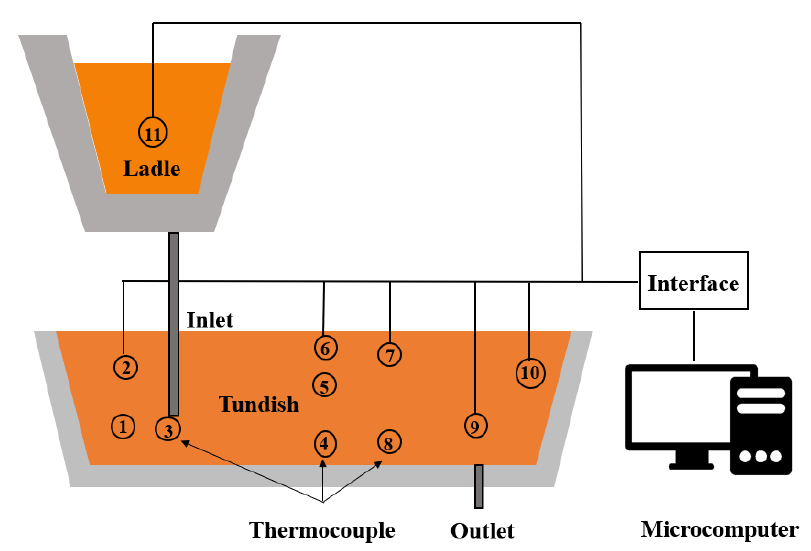
Figure 2. Schematic diagram of the experimental setup for physical modelling. Dynamic similarity is determined by requiring the Froude number in the water model, which is equivalent to that in the prototype, as shown in Equation